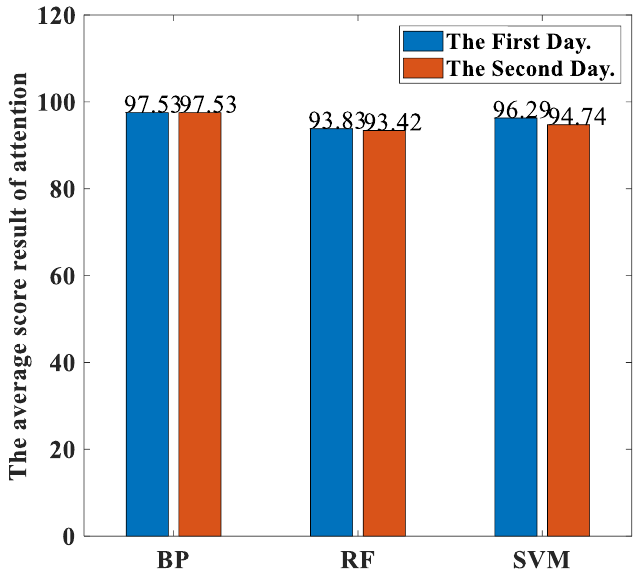
Figure 17. The percentages of the classification accuracies yielded by our proposed method with three different classifiers trained using the EEGs acquired from Hejian performing the reading activity under the concentration state on both the first day and the second day.